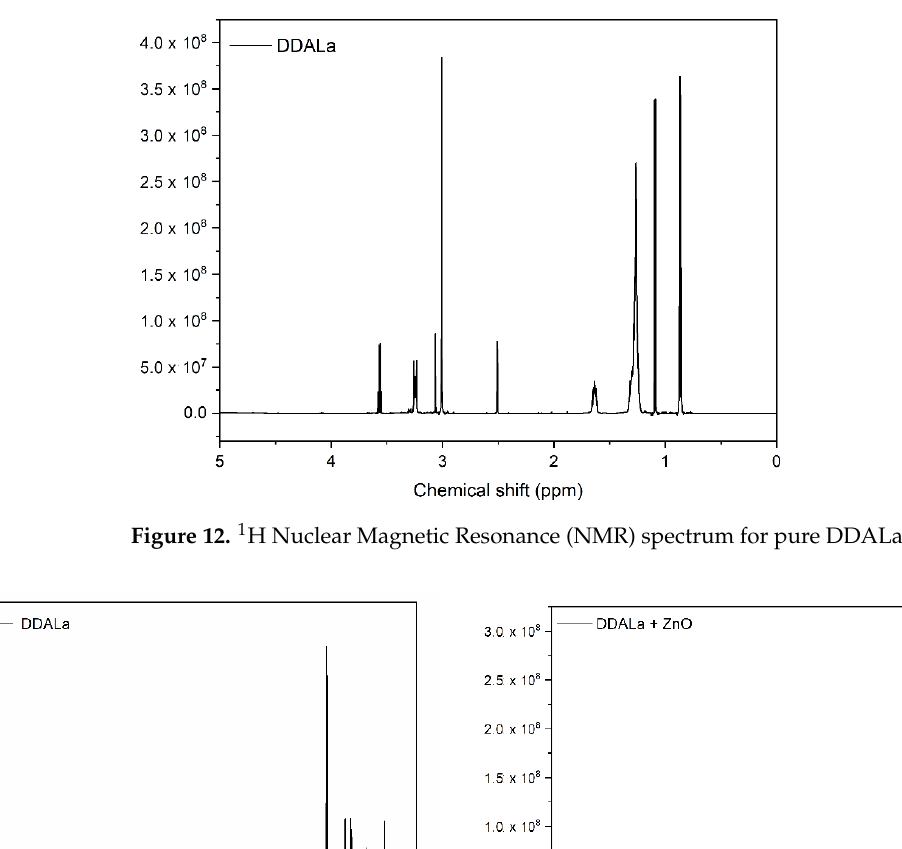
Figure 11. Structural formula of DDALa with marked carbons.